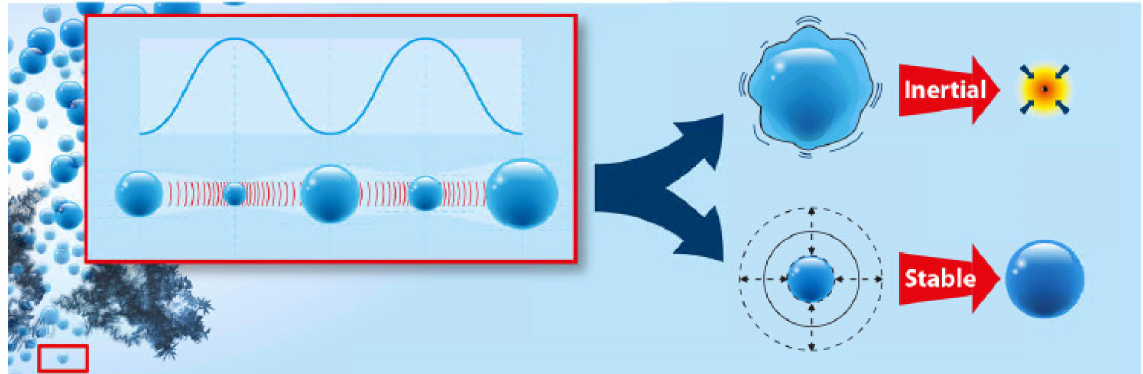
Figure 2. Display of the two possible cavitation modes, reprinted with permission from [38], Copyright (2013) American Chemical Society. The bubble size oscillation with ultrasonic pressure waves is indicated in the left part of the scheme. Depending on the power, this leads to transient (inertial) cavitation, that is, instable bubbles that collapse after a few oscillation cycles, or stable bubbles that oscillate in size over many more ultrasonic wave cycles.